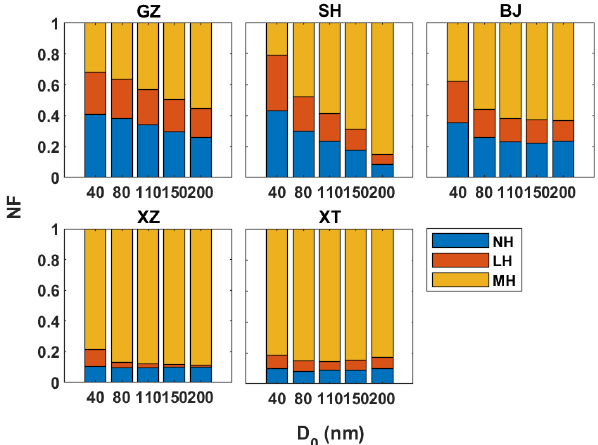
Figure 5. Campaign-averaged number fraction (NF) of nearly hy- drophobic (NH; blue), less hygroscopic (LH; orange), and more hy- groscopic (MH; yellow) groups for 40–200nm particles at each